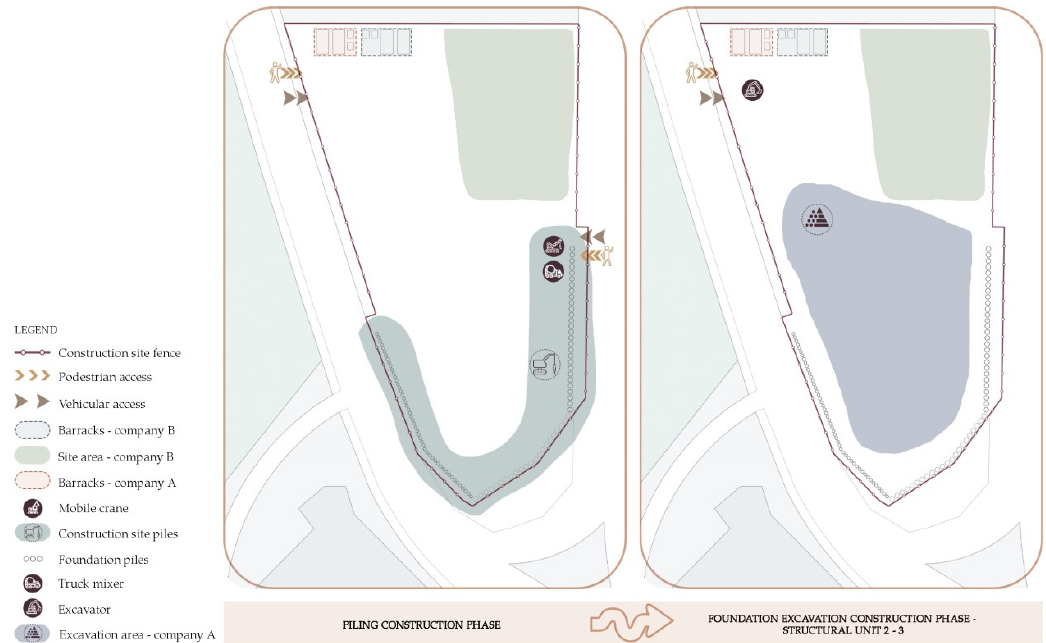
Figure 4. Piling construction and foundation excavation structural units 2–3 layouts—Case study.